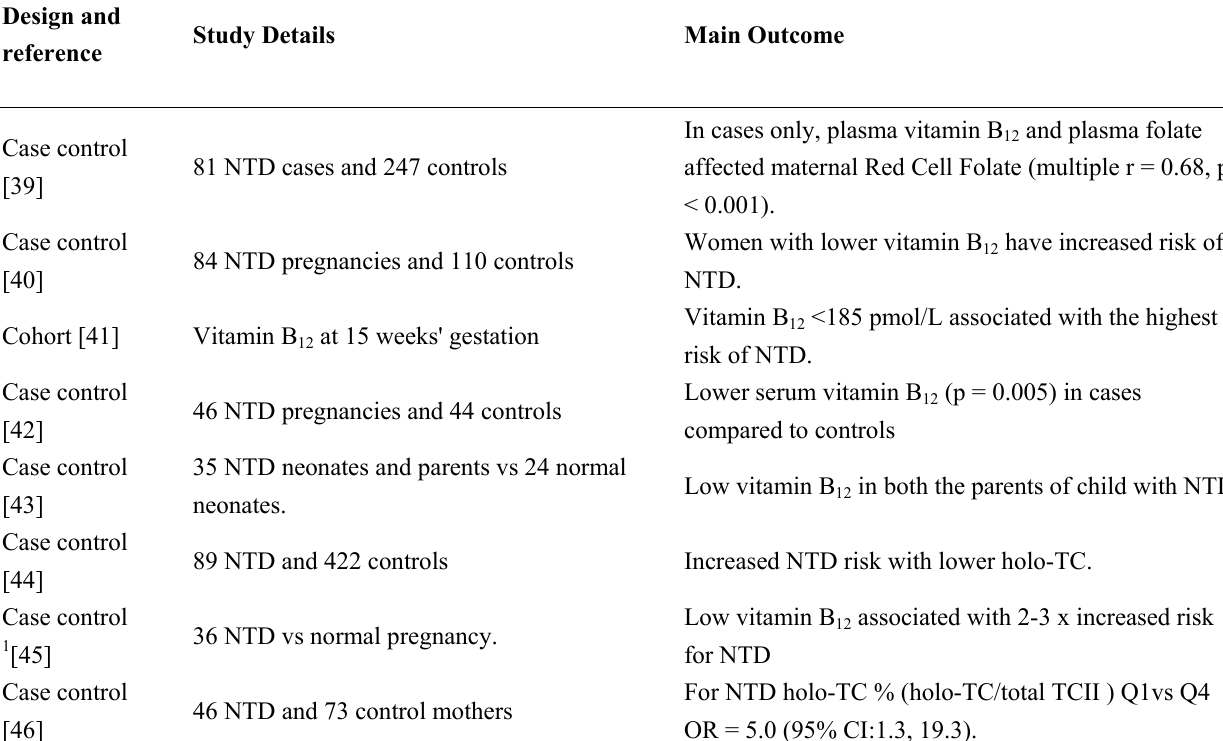
and Neural Tube 12